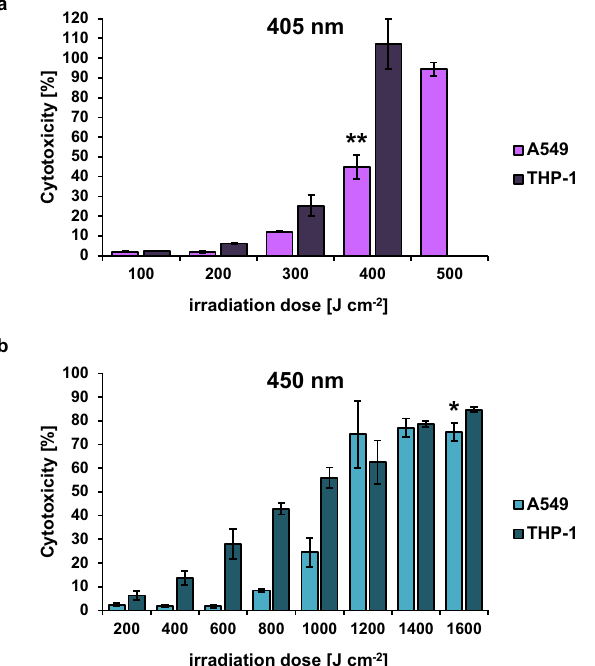
Figure 1. Light induced cytotoxicity in the human cell lines THP-1 and A549 measured by LDH activity. ( a ) Irradiation of cells at a wavelength of 405 nm. ( b ) Irradiation of cells at a wavelength of 450 nm. The values are expressed as % cytotoxicity of the positive control (TritonX-100 treated cells). The mean and standard deviation of three independent biological replicates with each three technical replicates are illustrated. The asterisk indicates statistically significant difference between the two cell lines (* p < 0.05; ** p <